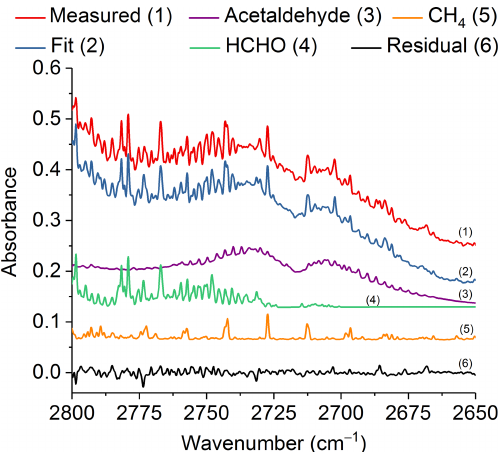
Figure 7. Measured and fitted spectra as well as the individual com- ponents (for clarity, the spectral contributions for acrolein, C 2 H 2 and H 2 O are not shown) and associated residual in the spectral re- gion 2800–2650cm − 1 . All spectra are at 0.6cm − 1 resolution and have been offset for clarity. The calculated mixing ratio of acetalde- hyde in this measured spectrum is